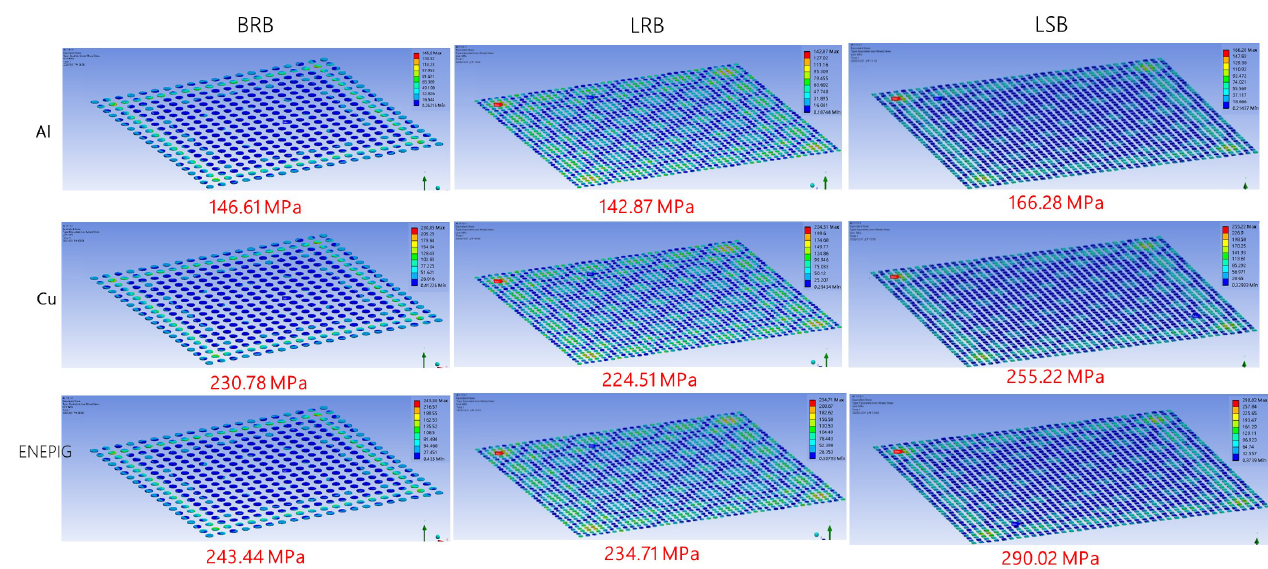
Figure 7. Stress distributions at the bonding interface when bump thickness was 10 µ m.